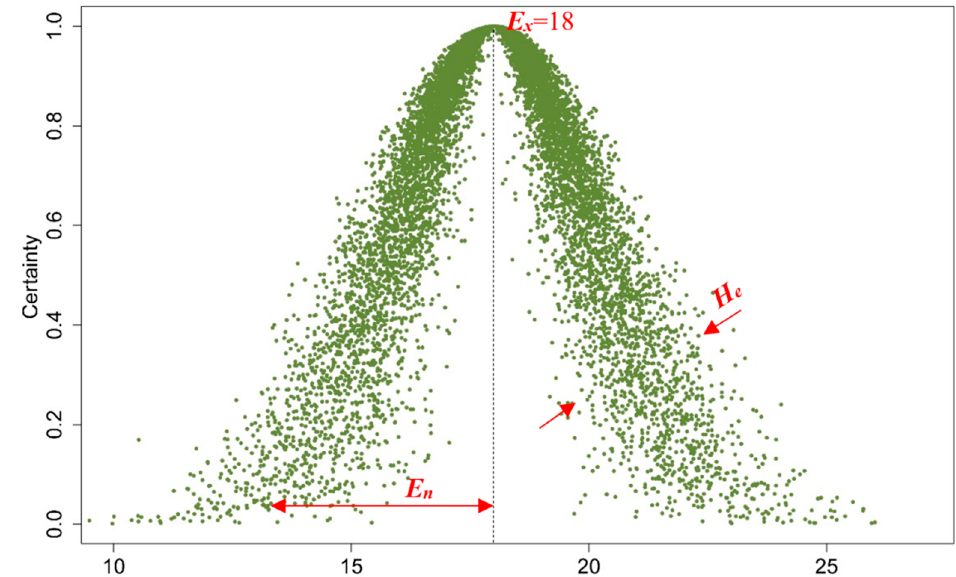
Figure 3. Schematic diagram of the cloud ( N = 50,000).